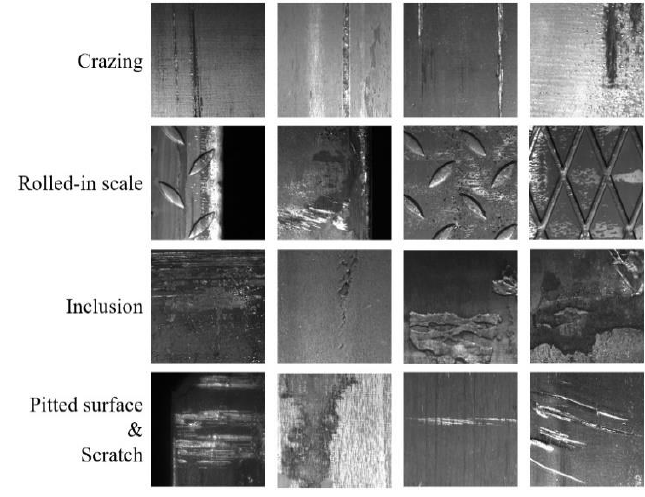
Figure 1. Types of defects in the steel manufacturing process [6].